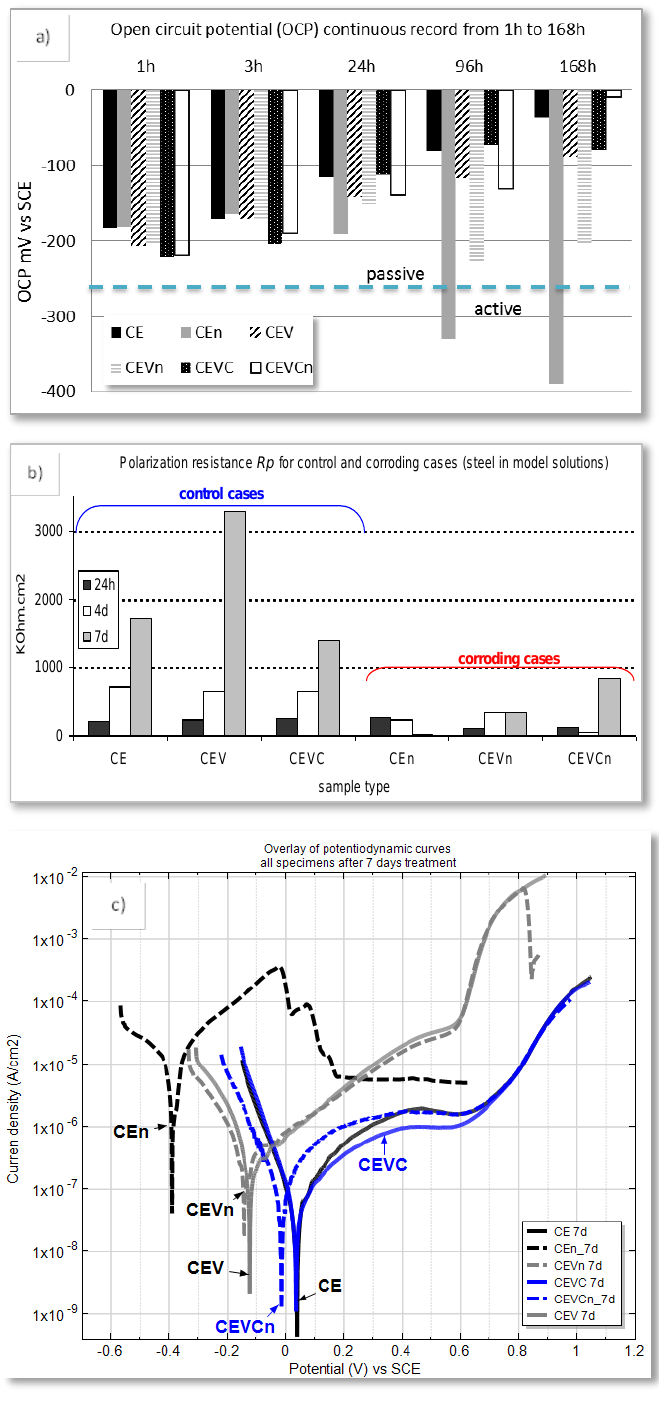
Figure 6. Electrochemical parameters derived for steel electrodes in model solutions: ( a ) Open circuit potential OCP records; ( b ) Polarization resistance Rp values and ( c ) Potentio-dynamic PDP response (specimens designation: CE—control, non-corroding; CEn—corroding: CEV—control, empty vesicles; CEVn—corroding, empty vesicles; CEVC—control, Ca-bearing vesicles; CEVCn—corroding, Ca-bearing